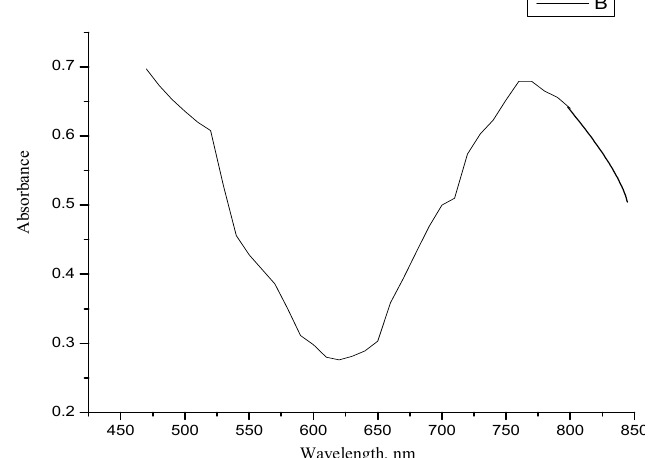
Figure 2. Absorption maximum of malathion with ammonium metavanadate.